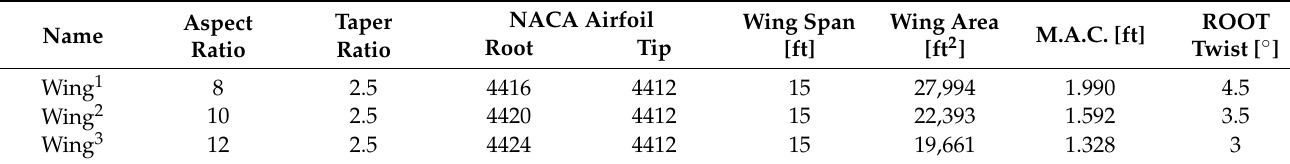
Table 1. Geometrical characteristics of the